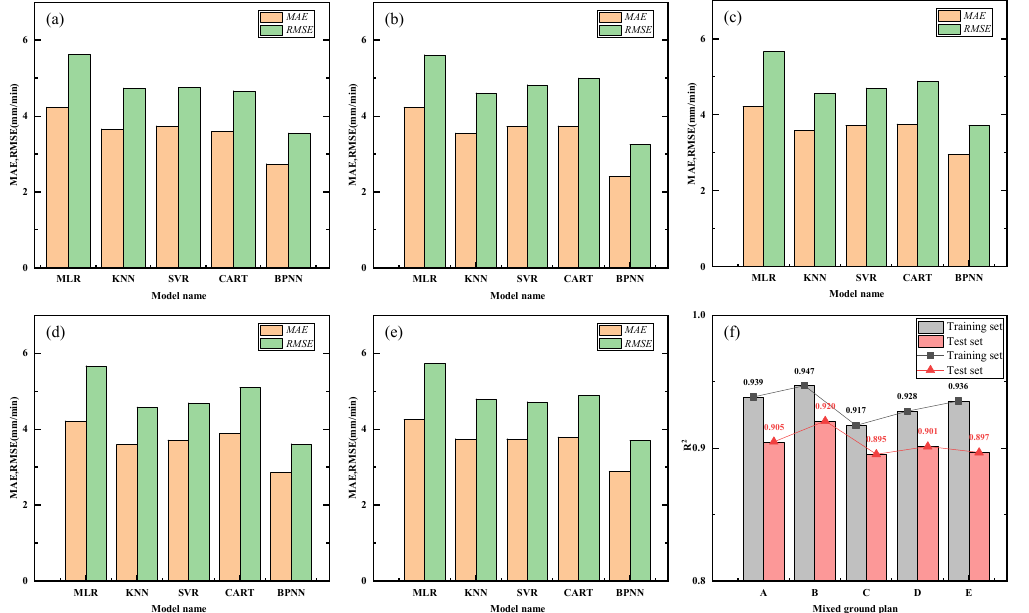
Note: Bold donates the lowest loss.